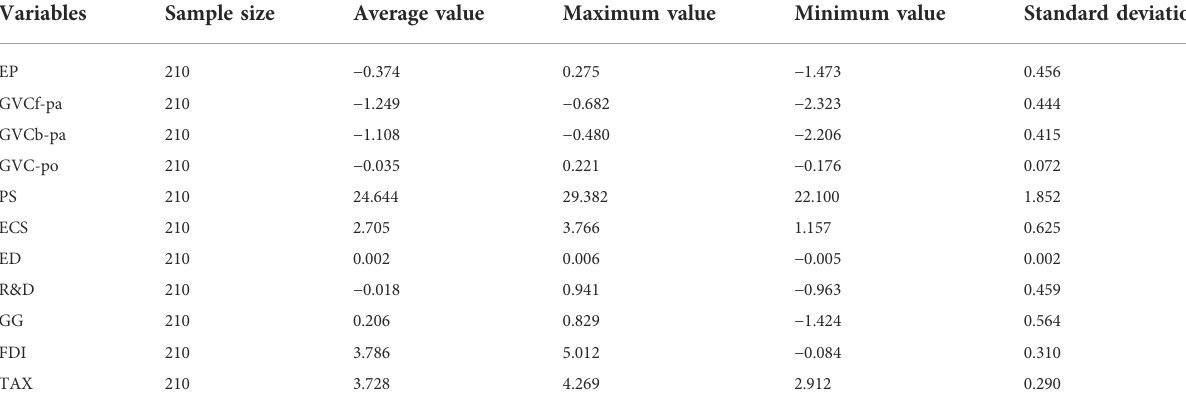
TABLE 2 Descriptive statistics.